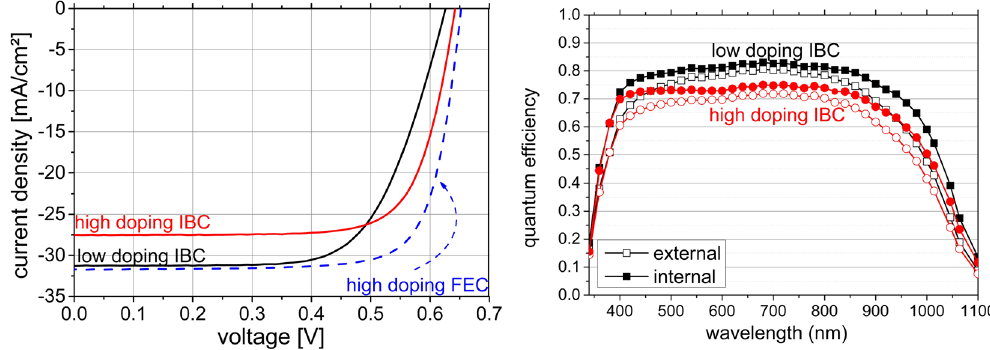
Figure 3. ( a ) J − V curves of the best IBC cells on LPC absorbers with high (red) and low (black) doping, respectively. The best FEC structure (blue) is added to demonstrate the potential of the absorbers. ( b ) External (open symbols) and internal (closed symbols) QE of the high (circles) and low (squares) IBC cells in 3a). FEC structure is omitted to not overload the graphic. J SC determined from integrating EQE curves corresponds well within errors with solar simulator data.